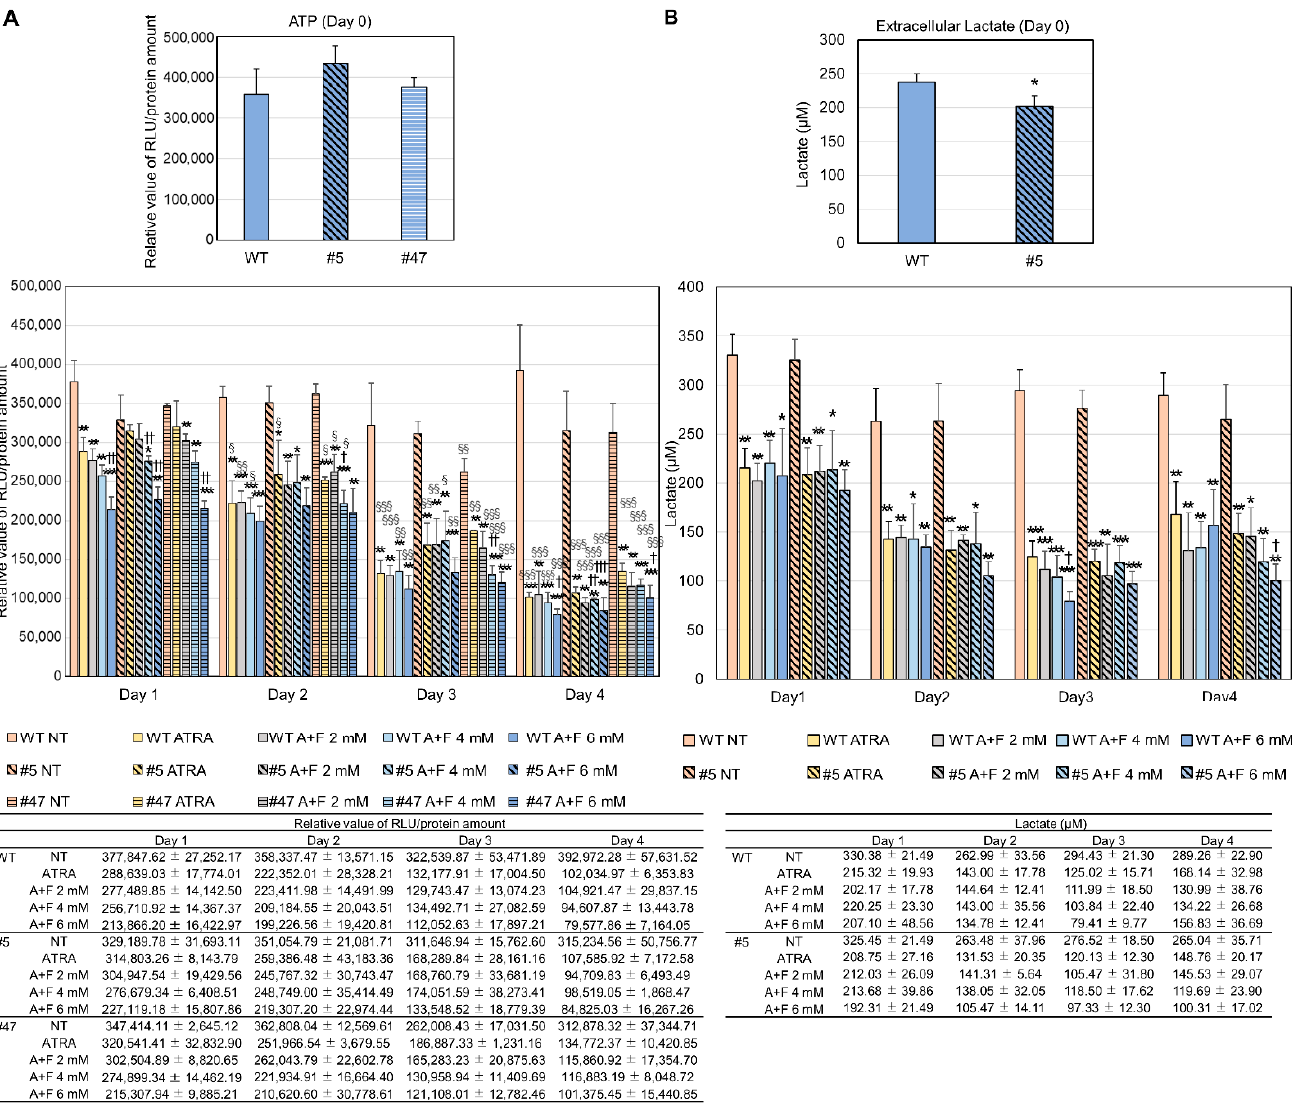
Figure 7. Metabolic changes during neutrophil differentiation with/without fructose in WT and clone(s). ( A ) The ATP levels in clones. (Top) The basic level of cellular ATP in WT and clones. Cells were untreated with ATRA or fructose. No significant difference in these groups. (Bottom) The cellular ATP production with and without fructose treatment during neutrophil differentiation for 4 days. Measured ATP amounts were corrected for each protein content. NT, non-treated; ATRA, all-trans retinoic acid; F, fructose. * p < 0.05; ** p < 0.01; *** p < 0.001 vs. NT. † p < 0.05; †† p < 0.01; ††† p < 0.001 vs. ATRA. § p < 0.05; §§ p < 0.01; §§§ p < 0.001 vs. Day 1. ( B ) The lactate levels in clones. (Top) The basic levels of extracellular lactate in WT and clones. Cells were untreated with ATRA or fructose. * p < 0.05. (Bottom) The extracellular lactate levels with and without fructose treatment during neutrophil differentiation for 4 days. * p < 0.05; ** p < 0.01; *** p < 0.001 vs. NT. † p < 0.05 vs. ATRA. No significant difference between WT and #5. Each point represents the mean ± standard deviation of three independent experiments.